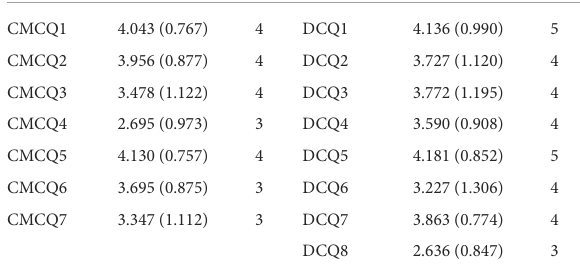
TABLE 4 Mean score, standard deviation, and mode for each item of the Computer-Mediated Communication Questionnaire (left) and Digital Commensality Questionnaire (right).